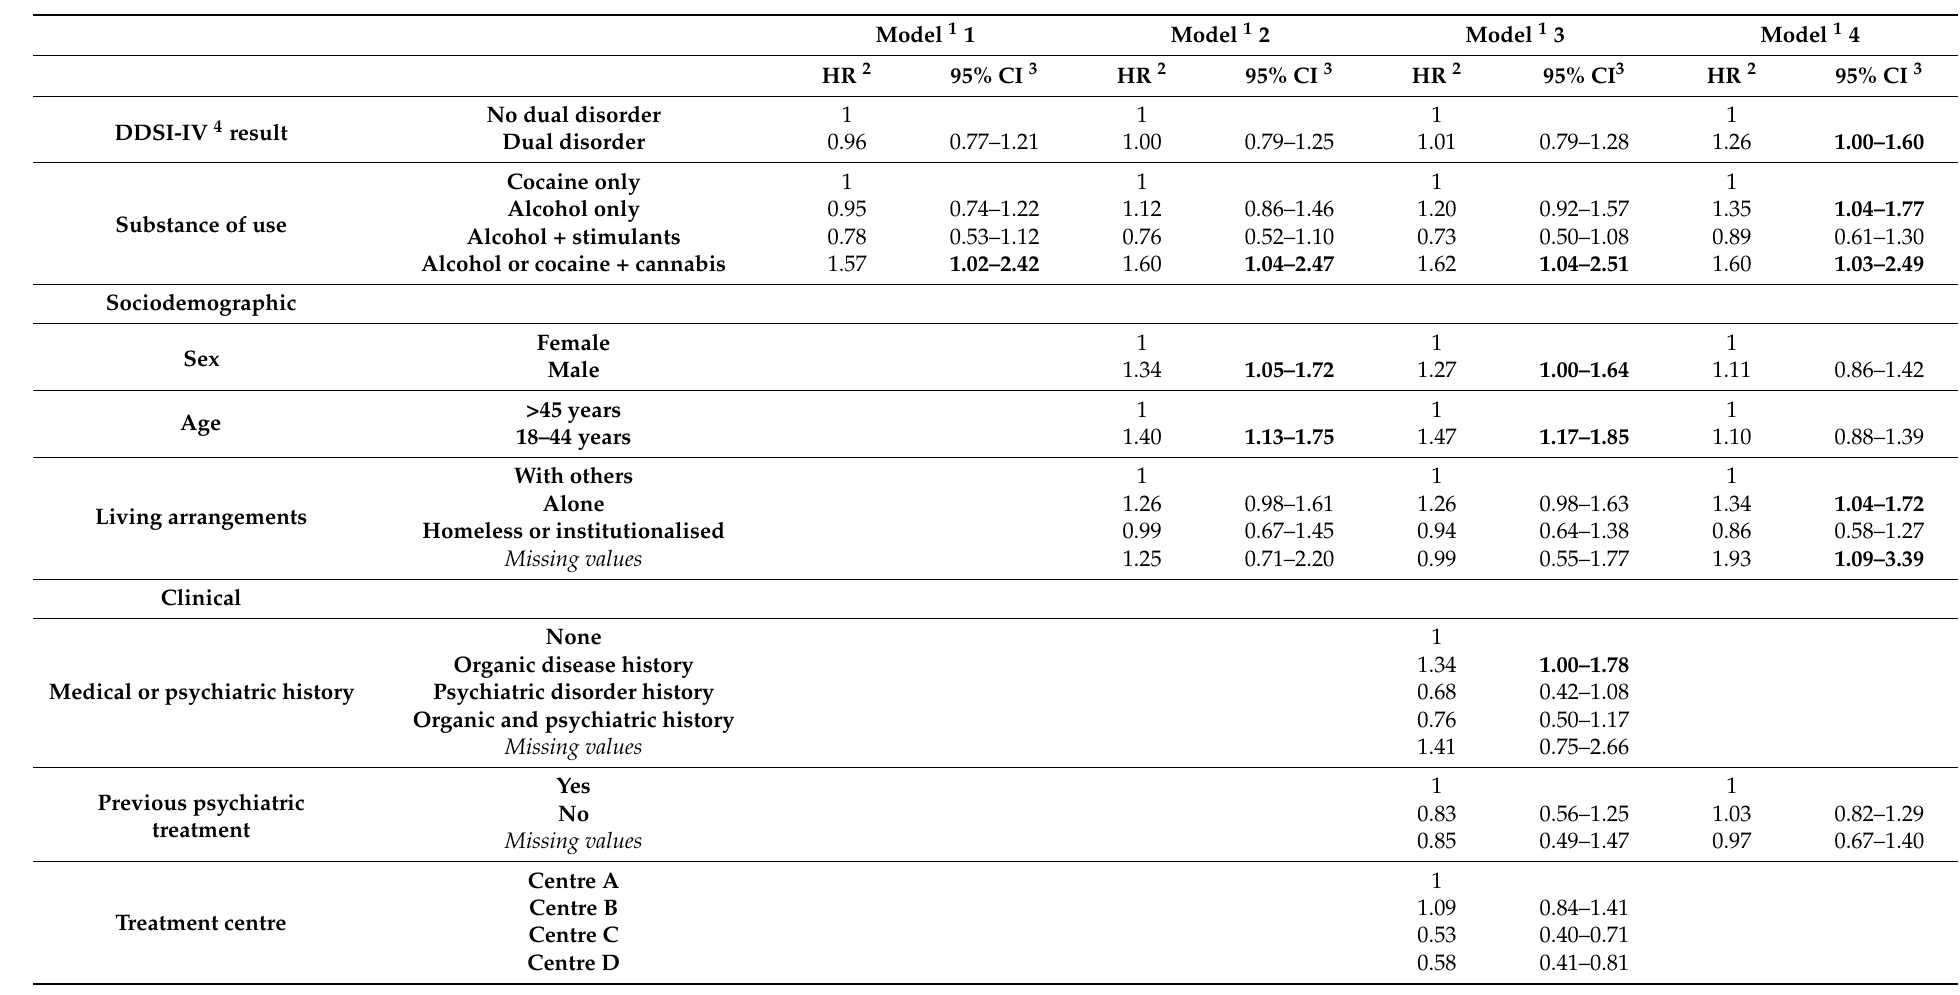
Table 2. Association of sociodemographic, clinical and follow-up characteristics and treatment dropout in a cohort of individuals with alcohol or cocaine